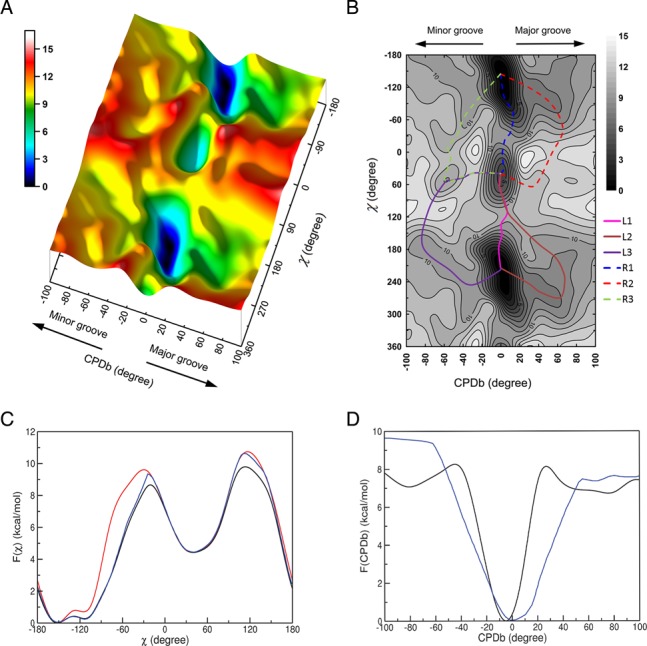
(A) Free energy landscape as a function of CPDb and χ-angles (in degrees) at 300 K. (B) 2D-free energy map with possible transition pathways denoted. The six transition pathways are named as R1, R2 and R3 for clockwise rotation of χ and L1, L2 and L3 for counterclockwise rotation of χ. 1D-free energy profiles along (C) χ and (D) CPDb. In the panels of (C) and (D), the black lines represent effective 1D-PMFs, which were obtained by using \documentclass[12pt]{minimal}
\usepackage{amsmath}
\usepackage{wasysym}
\usepackage{amsfonts}
\usepackage{amssymb}
\usepackage{amsbsy}
\usepackage{upgreek}
\usepackage{mathrsfs}
\setlength{\oddsidemargin}{-69pt}
\begin{document}
}{}$F(\chi ) = - RT \cdot \ln \left[ {\int {P(\chi ,CPDb)dCPDb} } \right]$\end{document} and \documentclass[12pt]{minimal}
\usepackage{amsmath}
\usepackage{wasysym}
\usepackage{amsfonts}
\usepackage{amssymb}
\usepackage{amsbsy}
\usepackage{upgreek}
\usepackage{mathrsfs}
\setlength{\oddsidemargin}{-69pt}
\begin{document}
}{}$F(CPDb) = - RT \cdot \ln \left[ {\int {P(\chi ,CPDb)d\chi } } \right]$\end{document}, where P(χ,CPDb) is the simulated 2D probability distribution function. The red line in the panel (C) represents 1D-PMF profile of χ-angle in the absence of base flipping (CPDb = 0°). The blue lines in the panels of (C) and (D) describe the lowest 1D-free energy paths with respect to χ and CPDb, respectively.